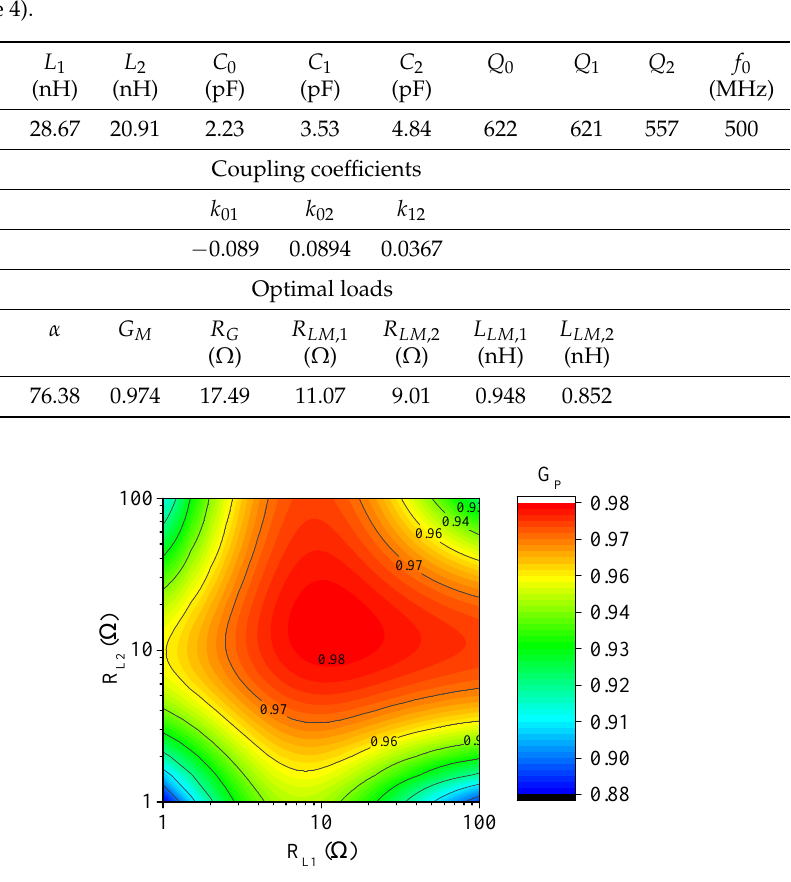
Figure 10. Power gain calculated through circuital simulations for case 4. Results obtained by varying the resistive part of the loads when the reactive parts are set according to the optimal values provided by the theory (see Table